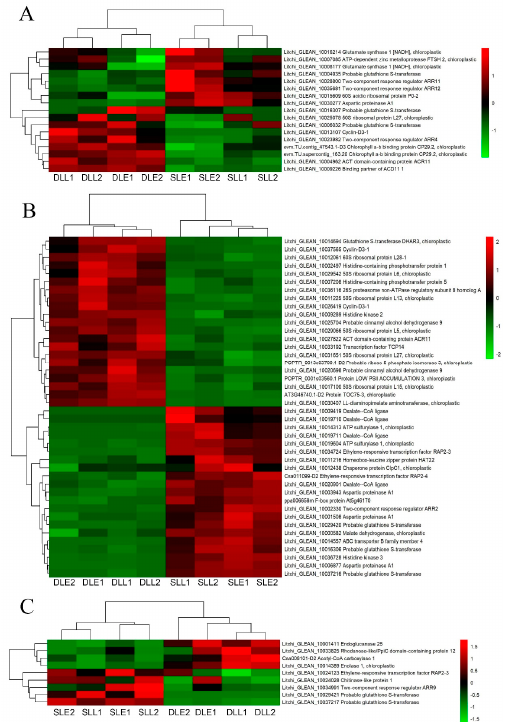
Figure 8. Heat map diagram showing the CTK-related differentially expressed genes (DEGs) between senescing and developing panicle leaves. ( A ) The unique DEGs expressed at an early stage. ( B ) The DEGs simultaneously expressed at early and later stages. ( C ) The unique DEGs expressed at a later stage. Litchi trees were transferred to a growth chamber at 18 ◦ C to induce panicle leaf senescence when panicle primordia emerged. The other trees were transferred to a growth chamber at 26 ◦ C to encourage panicle leaf development. FPKM values of the samples were normalized to